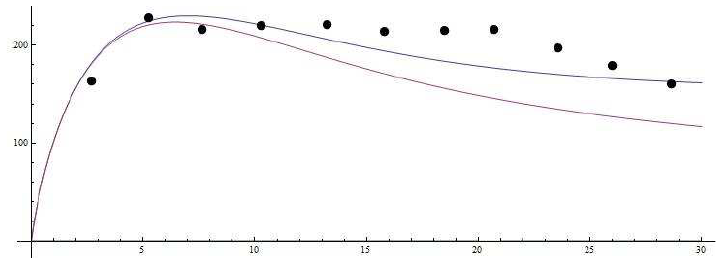
Figure 5. Rotation curve for galaxy NGC